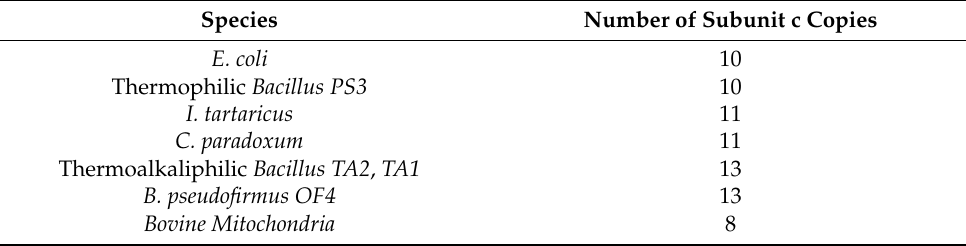
Table 1. Number of subunit c copies in ATPase of different species. This table represents bacterial and eukaryotic species and the disparity between the number of subunit c copies of their ATPase enzymes.